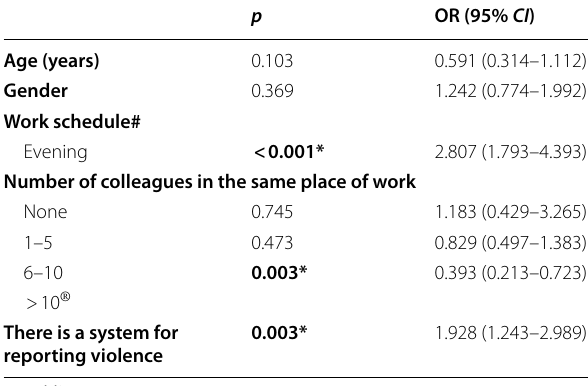
OR odd’s ratio, CI confidence interval, LL lower limit, UL upper limit # All variables with p < 0.05 were included in the multivariate * Statistically significant at p